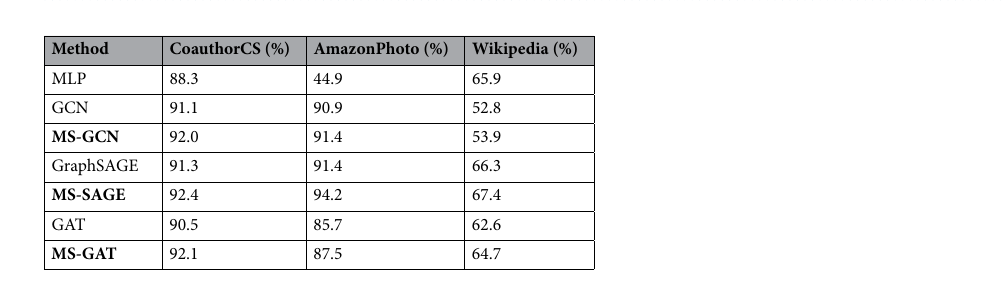
Table 5. Summary of results in terms of classification accuracies (other networks). Significant texts are in bold.